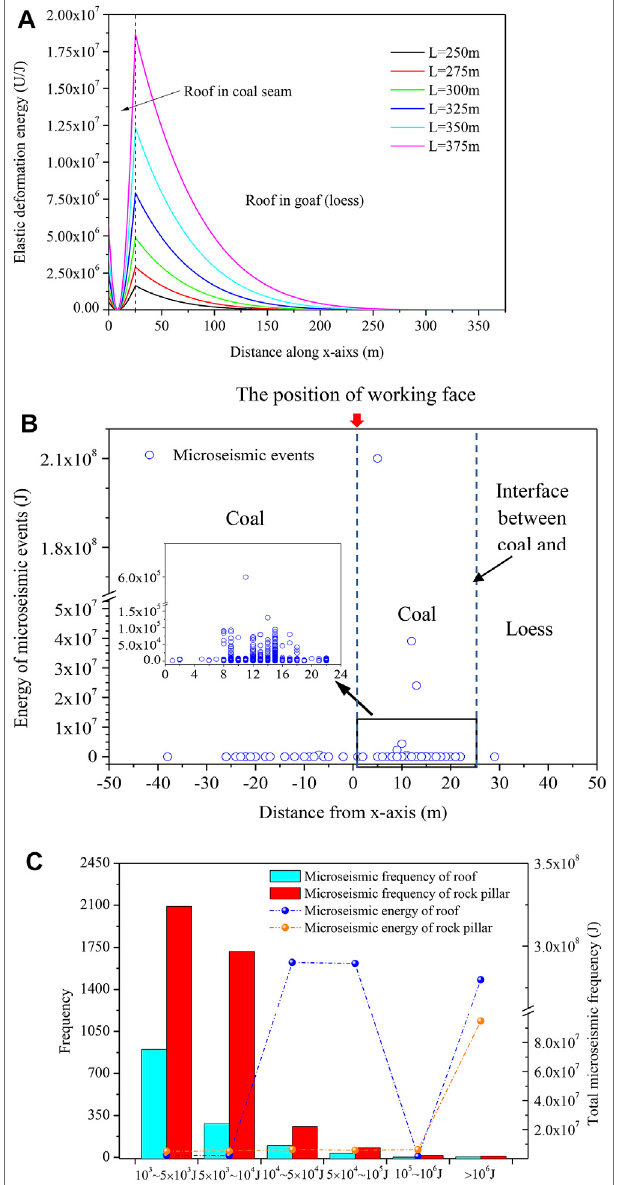
FIGURE7| Relationshipbetweenelasticdeformationenergyofroofand microseismic activity. (A) Variation curve of the elastic deformation energy of the roof along the coordinate axis x direction; (B) microseismic distribution at different positions of the roof ( “ 0 ” is the position of the working face; “ coal ” refers to the roof in solid coal; “ loess ” refers to the suspended roof); (C) statisticsofthe energy and frequency ofmicroseismic events inthe B3+6 coal seam at the +450 m level.